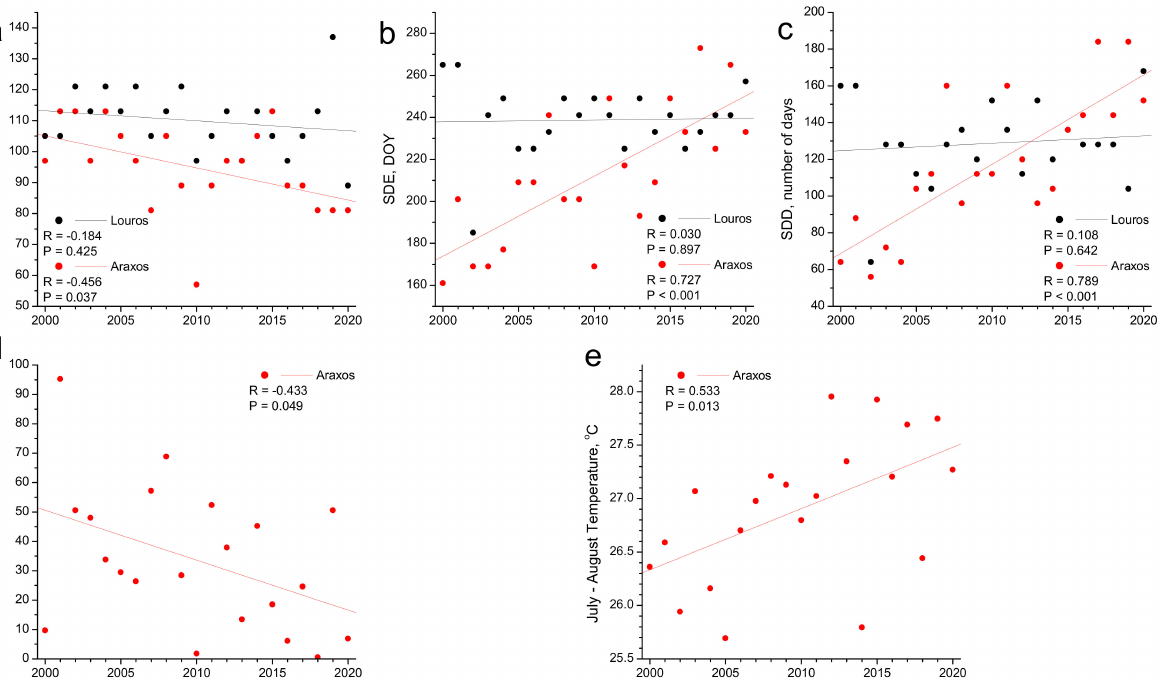
Figure 8. Interannual fluctuation of the spring drop related phenological events (dots) and their trends (lines) for the two study sites during the study period: ( a ) Spring drop onset (SDO,), ( b ) spring drop end (SDE), ( c ) spring drop duration (SDD. Interannual fluctuation of the main climatic parameters influencing the phenological events of the Araxos site (dots) and their trends (lines) during the study period: ( d ) April precipitation, ( e ) July–August